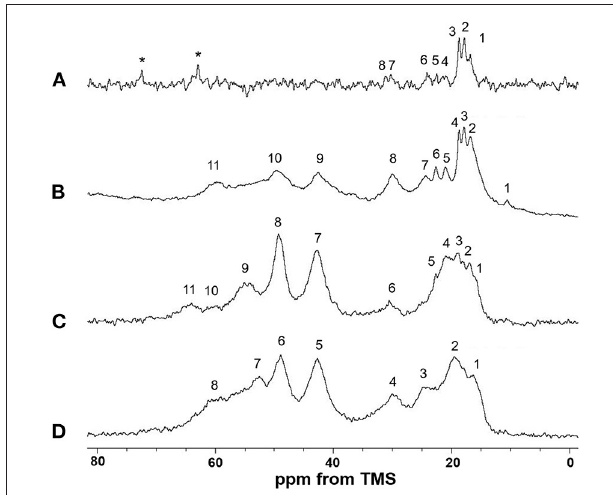
TABLE 1 | 13 C chemical shifts of 13 C solid-state NMR spectra of EL-SF